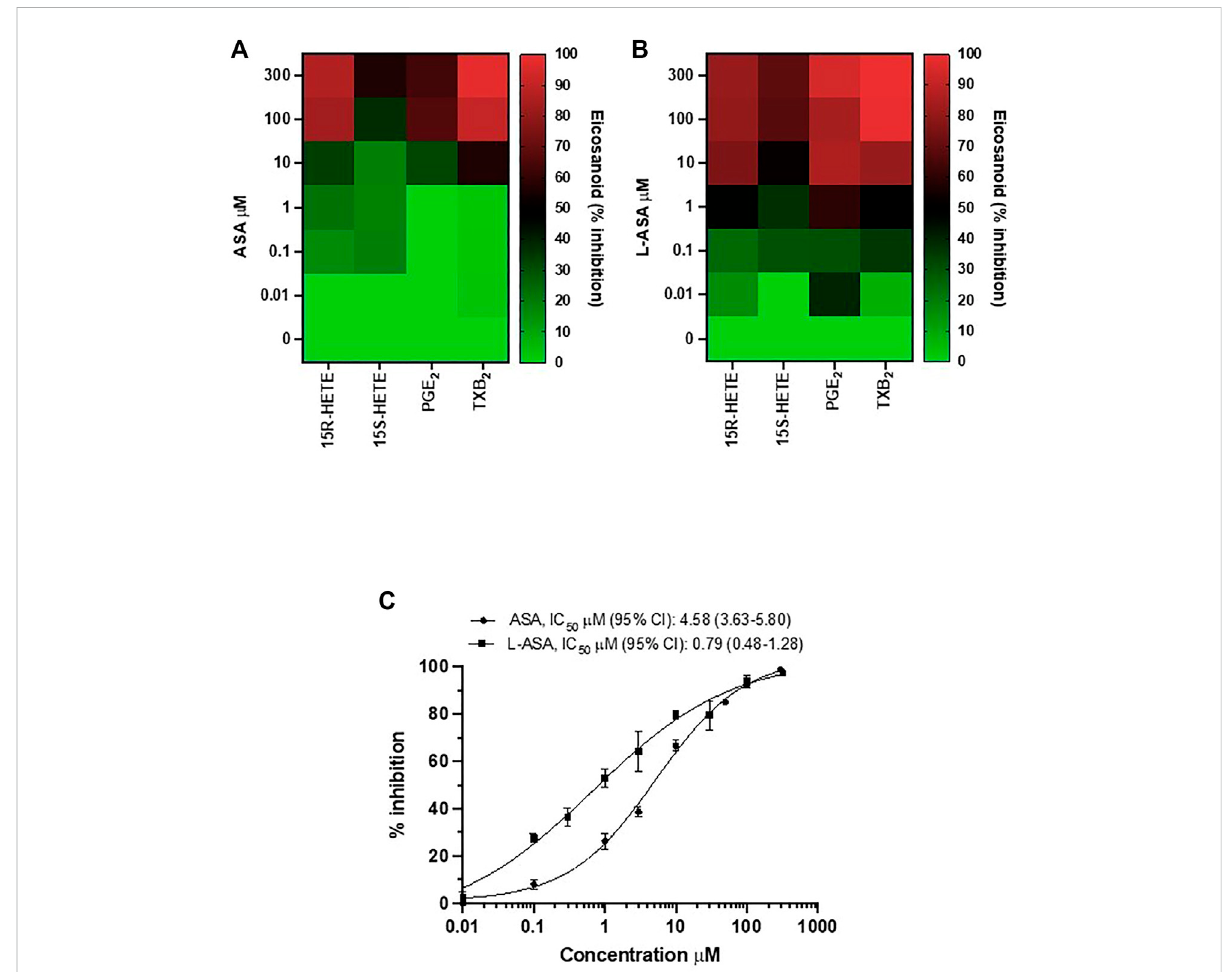
FIGURE 2 Comparison of the effects of Aspirin and L-ASA on eicosanoids generated from COX-1 in whole blood. Aliquots (1 ml) of whole blood were collected from healthy volunteers and incubated with increasing concentrations of ASA (0.01 – 300 μ M) or L-ASA (0.01 – 300 µM) or their vehicles (DMSOordiluent)for 1 hat37 ° C.Serumwasobtained bycentrifugation, and15S-HETEand 15R-HETE, PGE 2 , andTXB 2 levels weremeasured byLC- MS/MS. (A,B) Heat map of the effect of ASA and L-ASA on eicosanoids biosynthesis in serum (mean values of three separate experiments); results are reported as % of inhibition from baseline values, in the presence of DMSO or diluent, respectively. (C) Concentration-response curve for inhibition of serum TXB 2 by ASA and L-ASA using a validated and speci fi c immunoassay; results are reported as mean ± SD (n = 4 – 7) of % inhibition from baseline values, in the presence of DMSO or diluent, respectively; concentration-response curves were fi tted, and IC 50 with 95% Con fi dence Interval (CI) values were